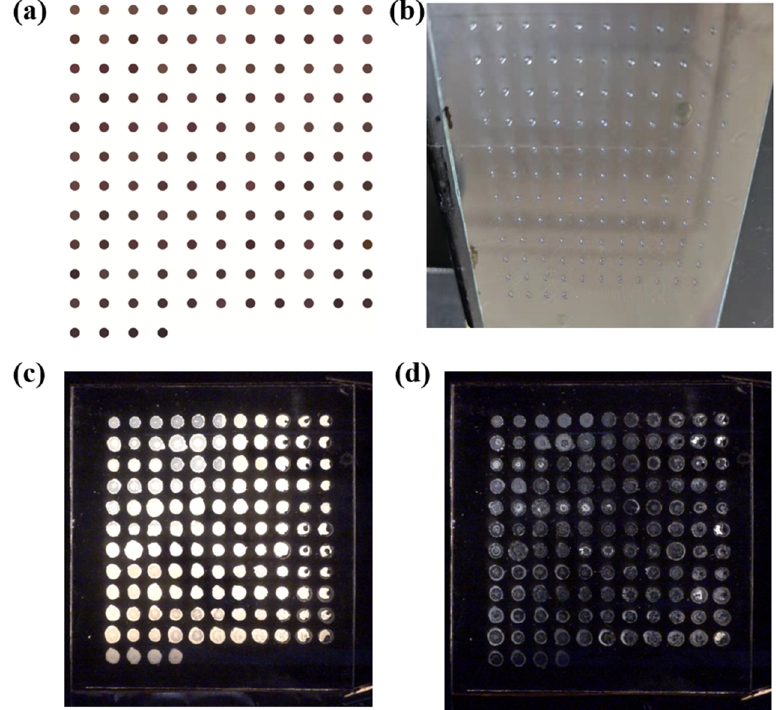
Figure 2. ( a ) Color fill pattern corresponding to 125 sample points based on CMYK mode; ( b ) Pho- tographs of 125 samples obtained by inkjet printing; ( c ) Photographs of 125 samples between crossed polarizers without electric field; ( d ) Photographs of 125 samples between crossed polarizers under electric field.